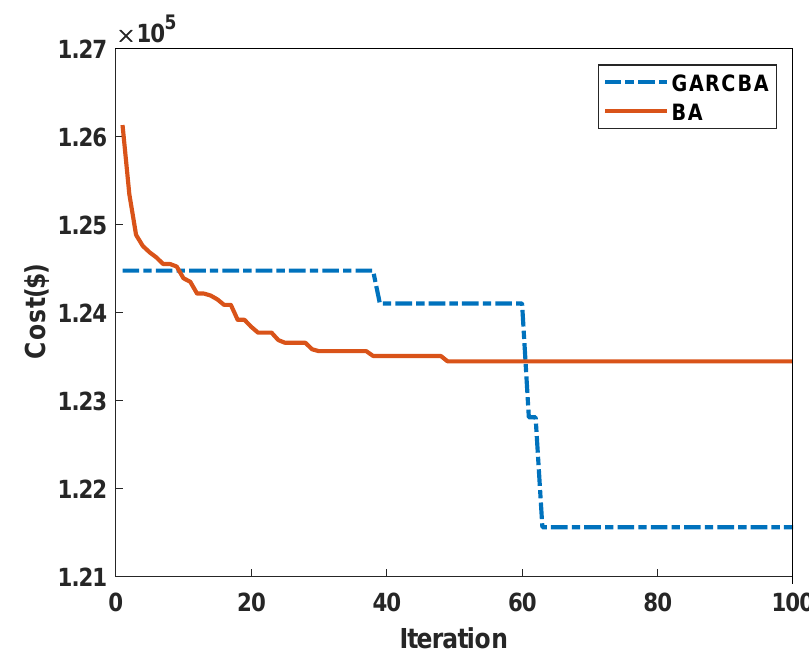
Figure 3. The convergence characteristics of BA and GARCBA in Case 3.1.